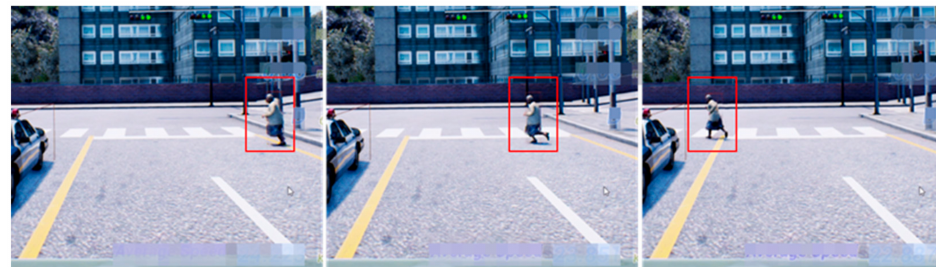
Figure 19. The running of the interrupt event function.